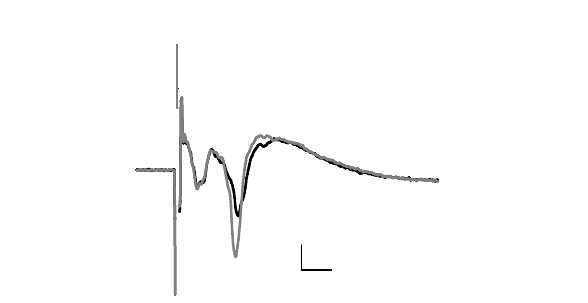
the lateral amygdala. (A) ± CNQX (10 μ M); (B) ± TTX (100 nM). In each case, the black trace = baseline, grey trace = after drug; horizontal scale bars 2 ms, vertical 0.2 mV.